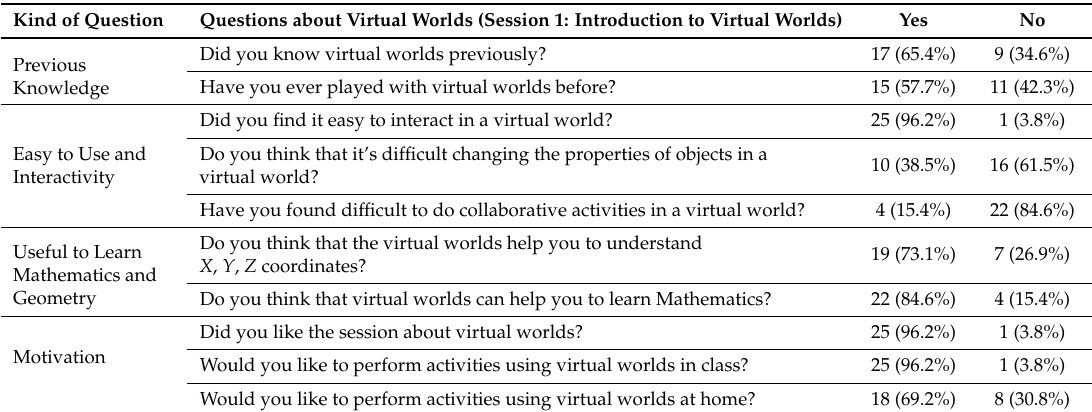
Table 2. Result of the survey about previous knowledge on virtual worlds (26